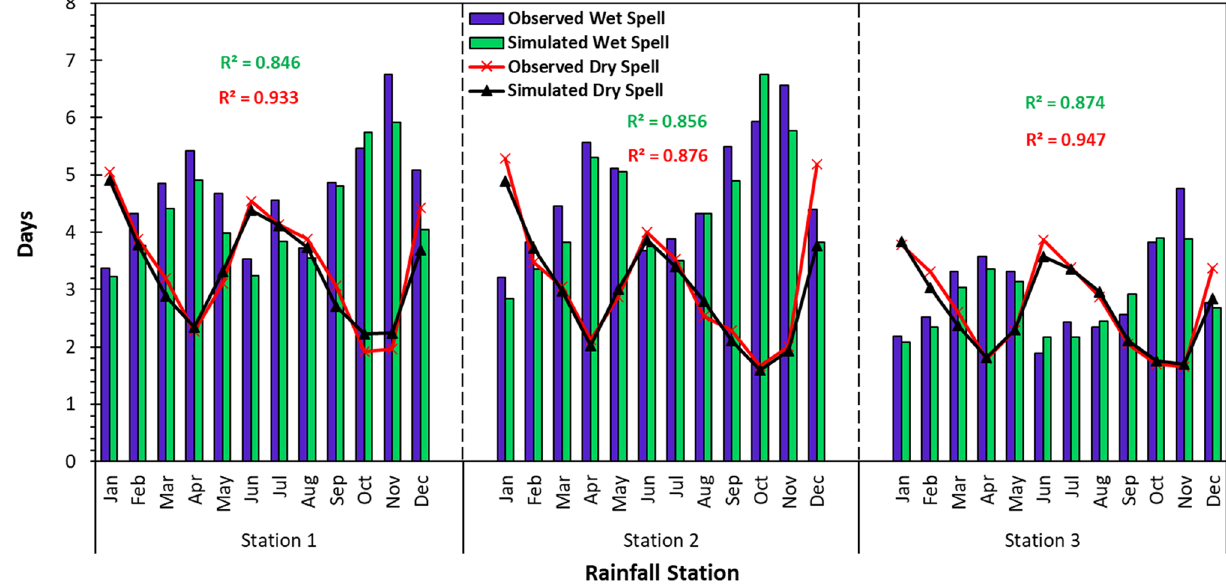
Fig. 4 Comparison of rainfall observed and simulated wet and dry spells for each